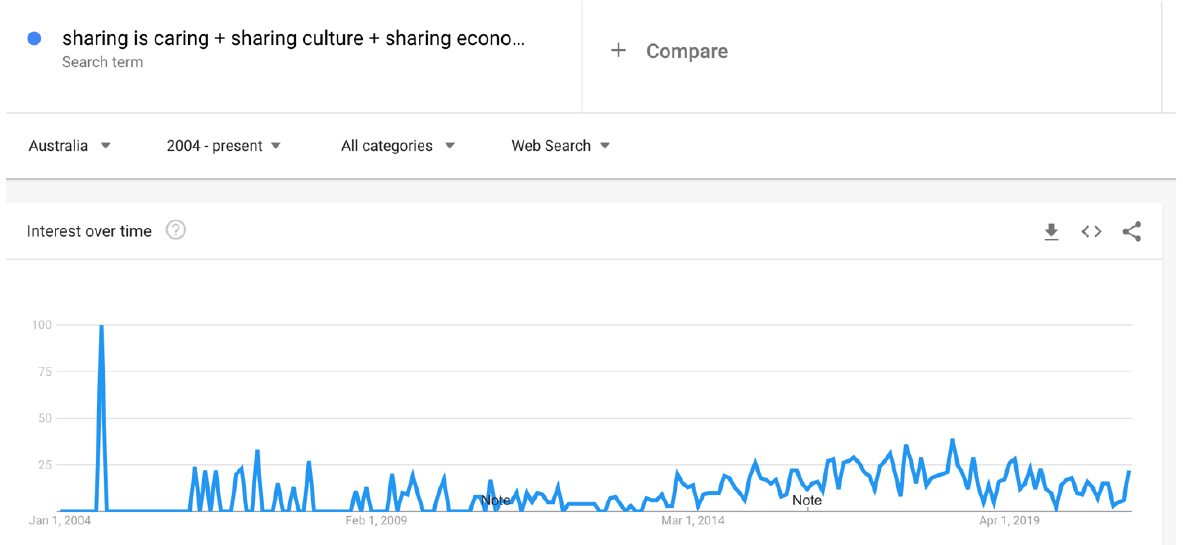
Figure 3: Combined sharing metaphor Search Query Index for ‘sharing is caring + sharing culture +